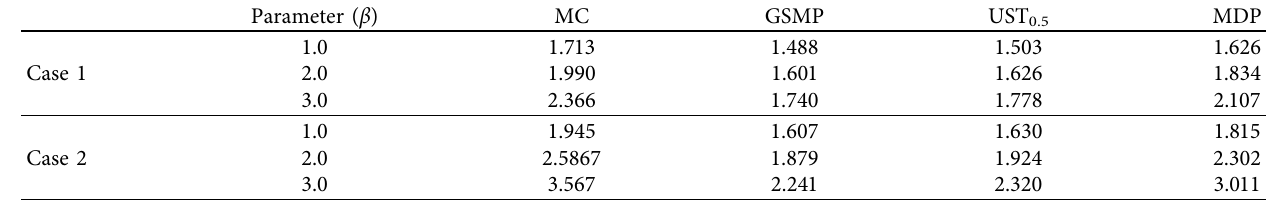
E / ( p R )) of the circular tunnel. 0 0 0